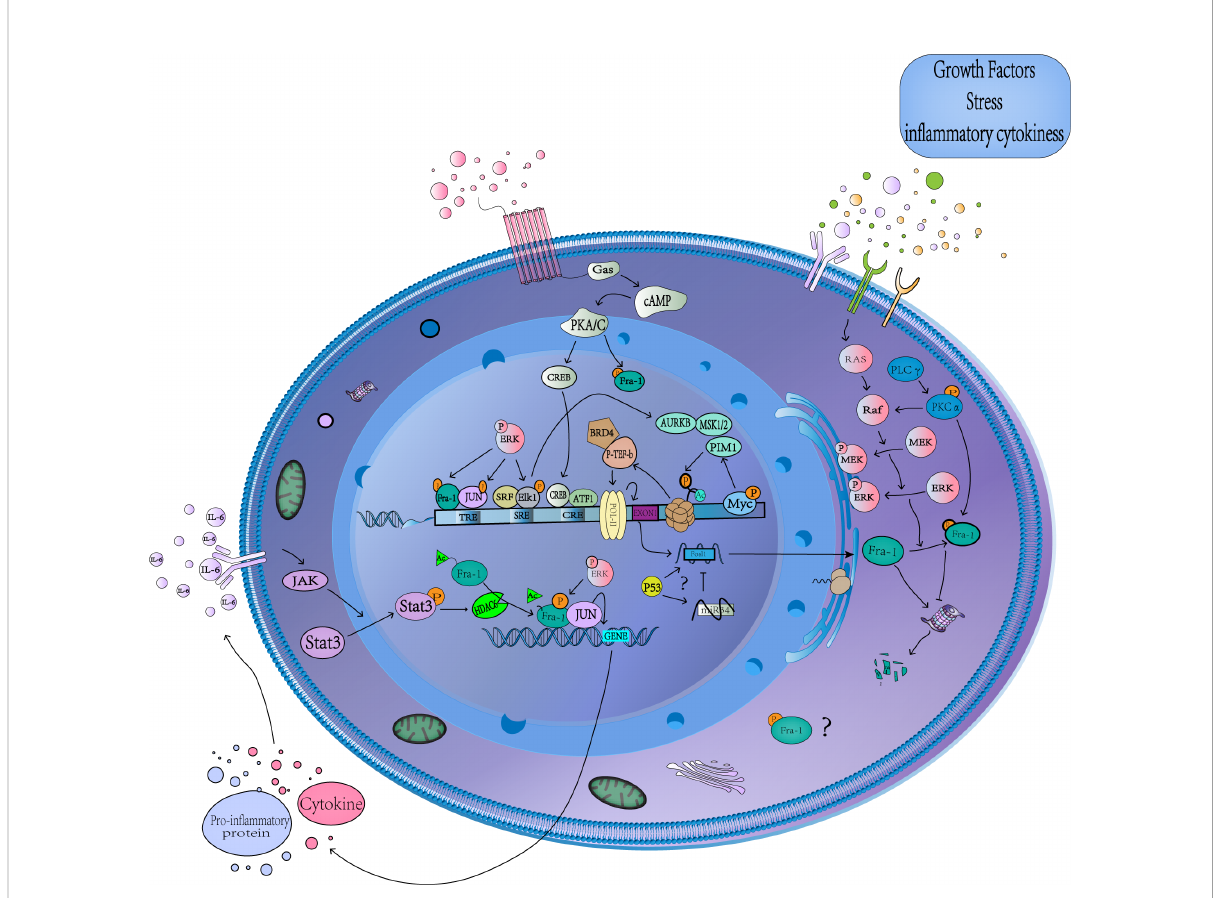
FIGURE 2 Transcriptional and posttranslational regulation of Fra-1. A schematic representation showing the multiple cellular pathways that converge to regulate Fra-1 function. Stimulation by various factors leads to MAPKs/cAMP/JAK-Stat3 activation, which in turn activates several TFs, causing the expression and phosphorylation of Fra-1, whose production regulation Fra-1 target gene expression. The unphosphorylated Fra-1 in the cytoplasm is easily degraded by proteasome. The question mark represents the unknow role of phosphorylated Fra-1 in the cytoplasm and the sepci fi c relationship between Fra-1, P53 and miR34. cAMP, Cyclic adenosine monophosphate; CRE, cAMP-responsive element; TRE, TPA reaction element; SRE, serum response element; PKA/C, protein kinase A/C; CREB, cAMP-response element binding protein; MSK1/2, Mitogen- and stress-activated kinases 1 and 2; ERK, extracellular regulated protein kinases; AURKB, Aurora Kinase B; P-TEFb, positive-elongation factor; BRD4, Bromodomain Containing 4; POL-II, polymerase II; ATF1, Activating Transcription Factor 1; Stat3, Signal transducers and activators of transcription 3; MAPK, mitogen-activated protein kinase; HDAC6, Histone Deacetylase 6; IL-6, interleukin-6; SRF, Serum response factor; JAK, janus kinase; RAS, rat sarcoma; Raf, Raf protein kinase; PLC, Phospholipase